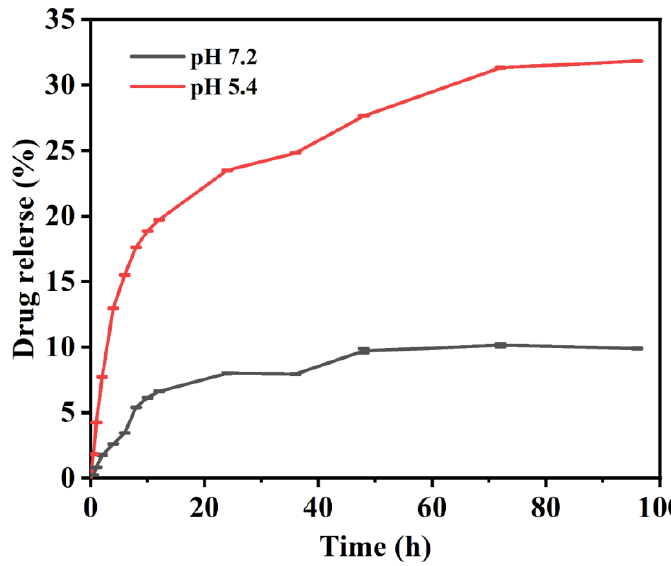
Figure 8. The release behavior of HAP − HE@PEI@DOX to DOX at pH 7.2 and